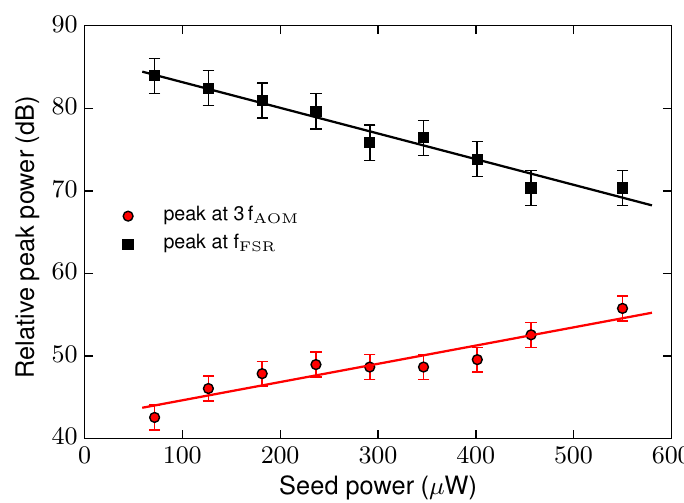
Figure 5: Dependence of the broadband signal at the frequency f feature at 3 f (red circles) on seeding laser power and linear fits to the data. The relative AOM peak power is obtained by integrating peaks such as the ones shown in Fig. 3a2 and 3b2 over frequency and comparing them to the noise